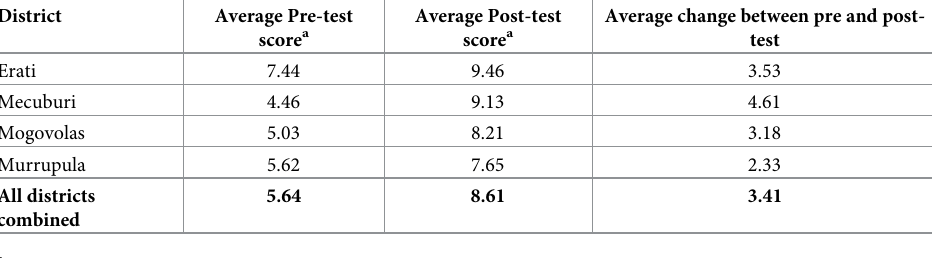
Table 6. CDFs pre- and post- training test